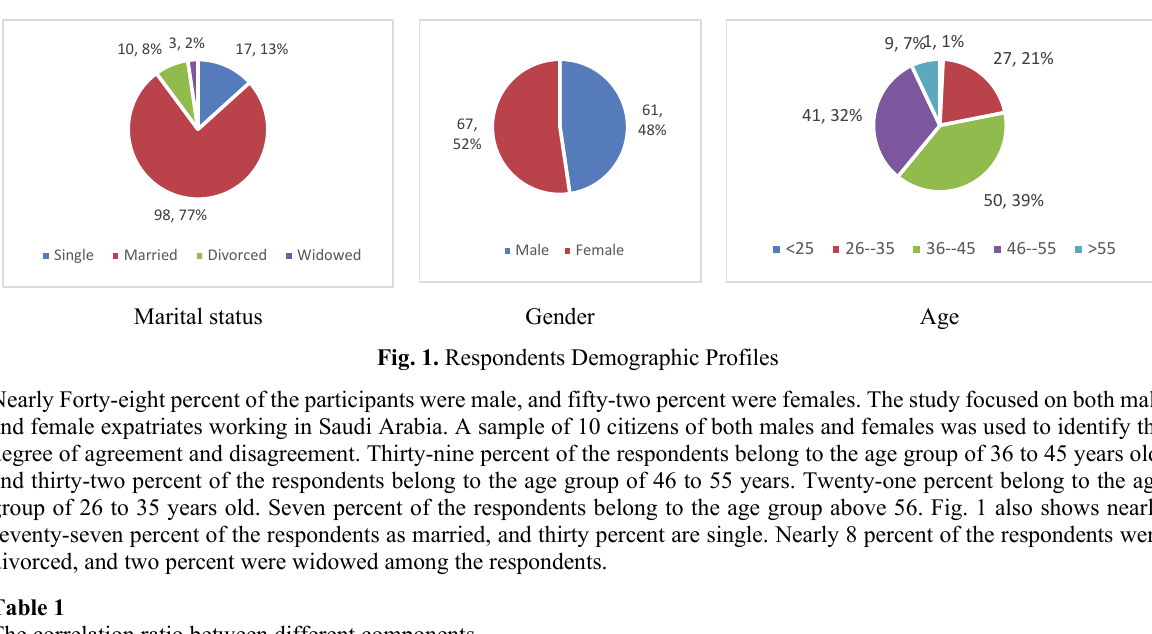
The correlation ratio between different components